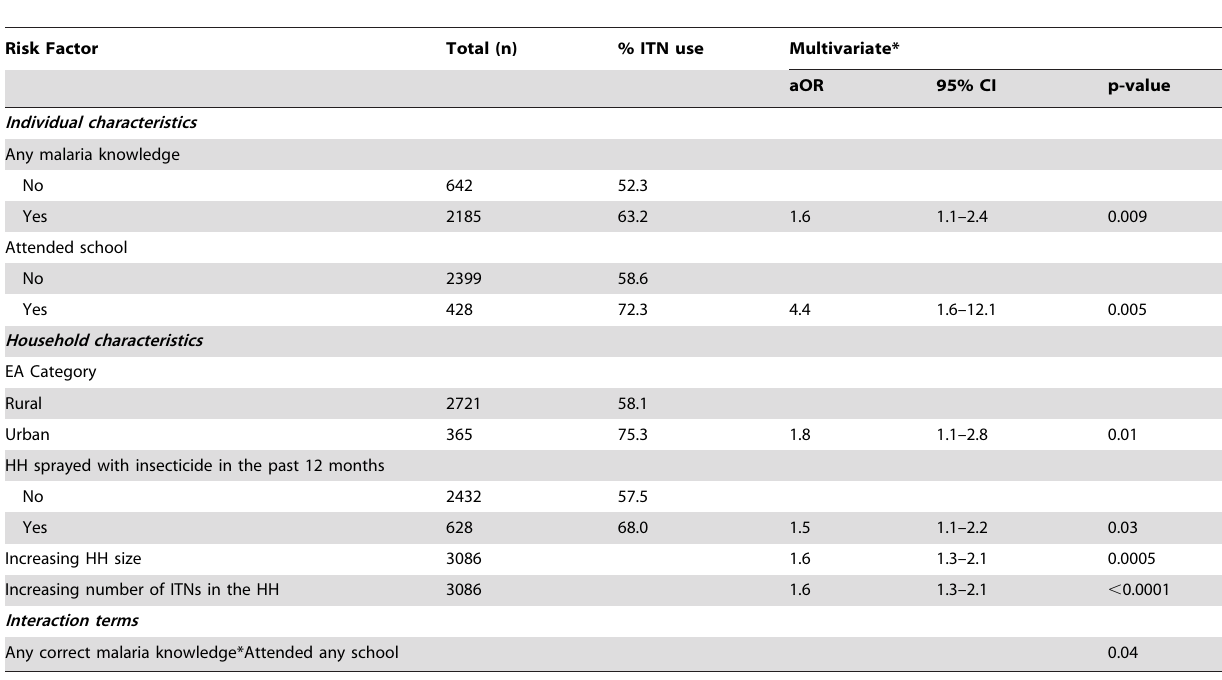
Table 6. Knowledge of malaria amongst mothers of children U5 as it predicts ITN use for their children U5 in households that own at least one